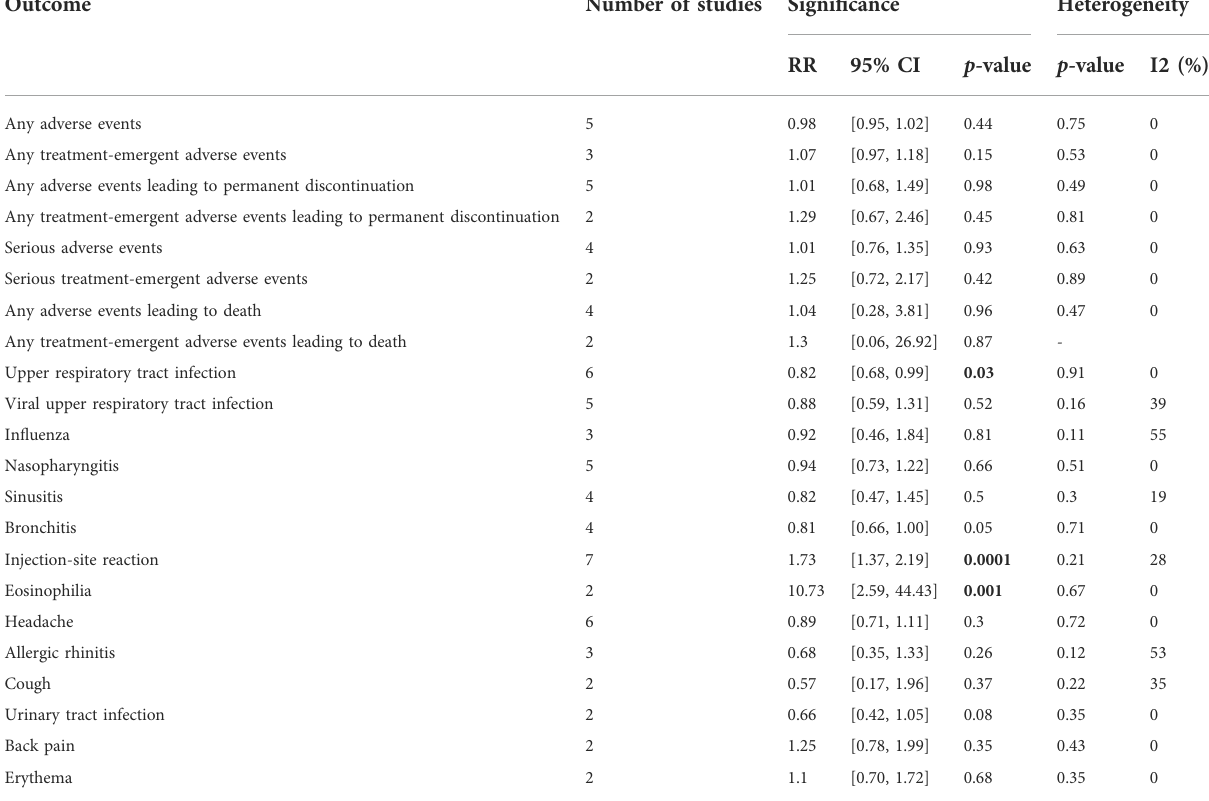
TABLE 3 Details of the adverse events results of the included